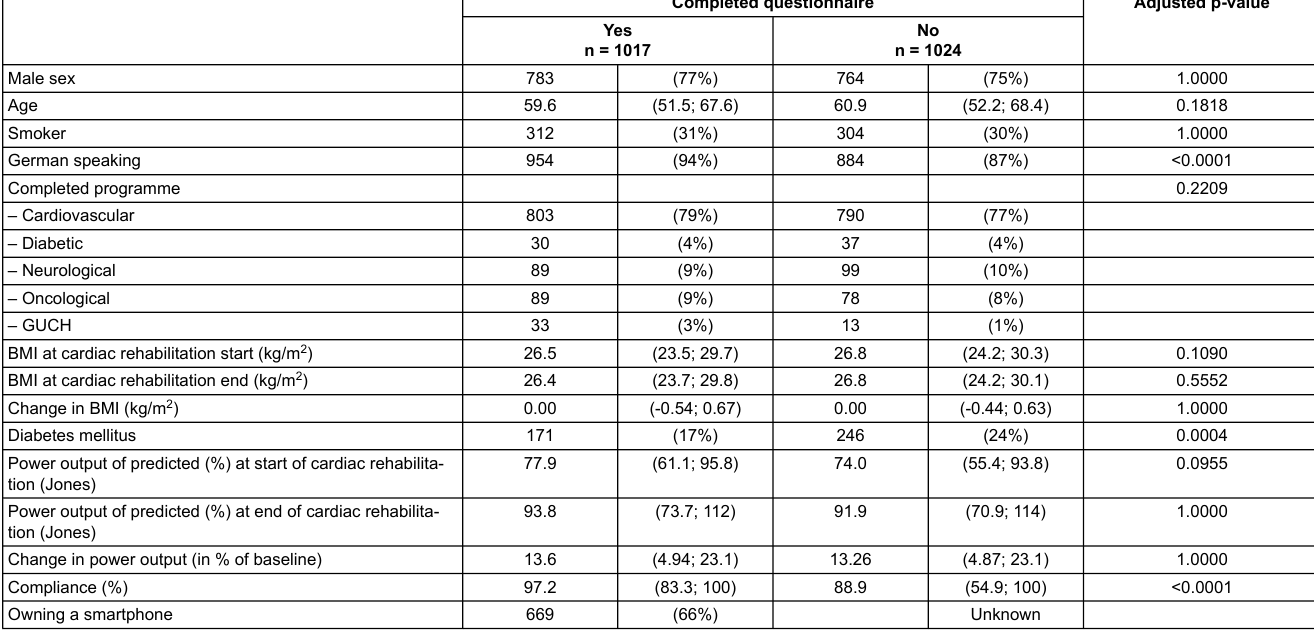
Completed questionnaire